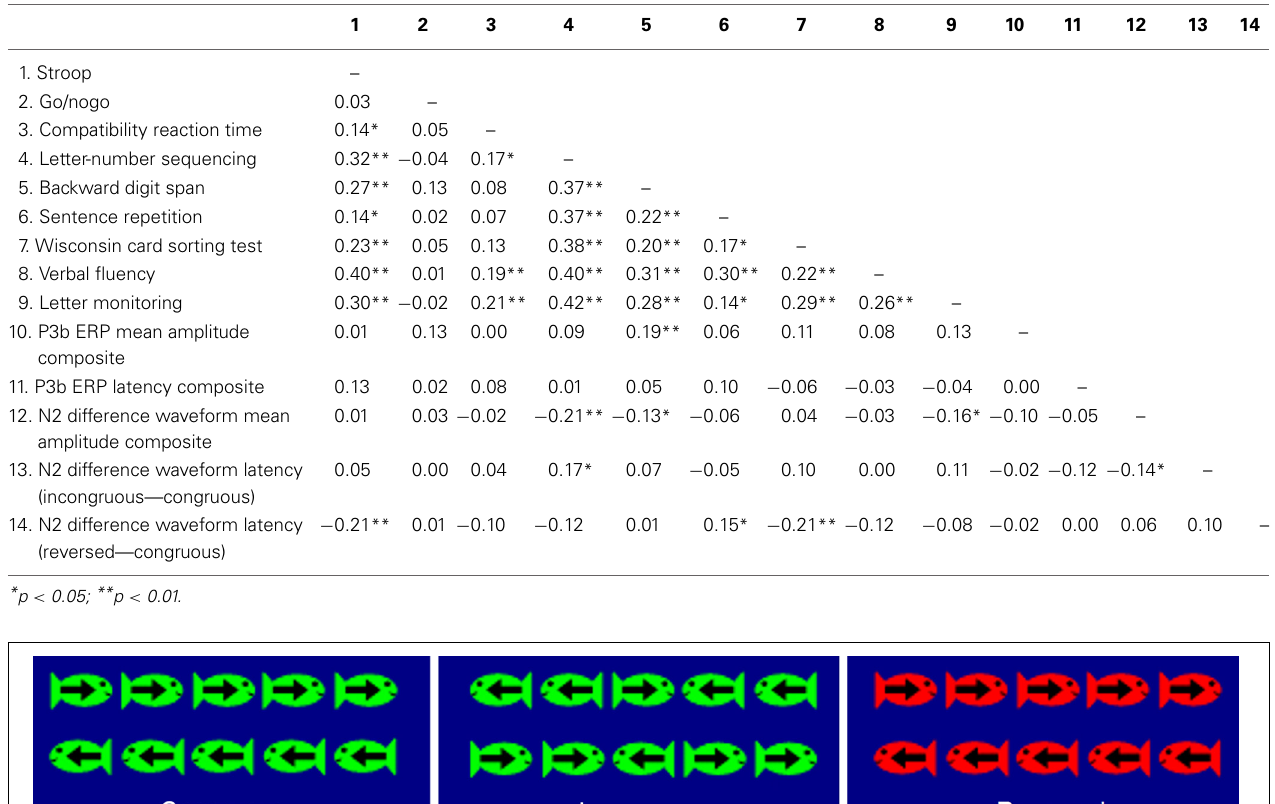
Table 2 | Correlations between measures of executive functioning and ERPs ( N = 215).